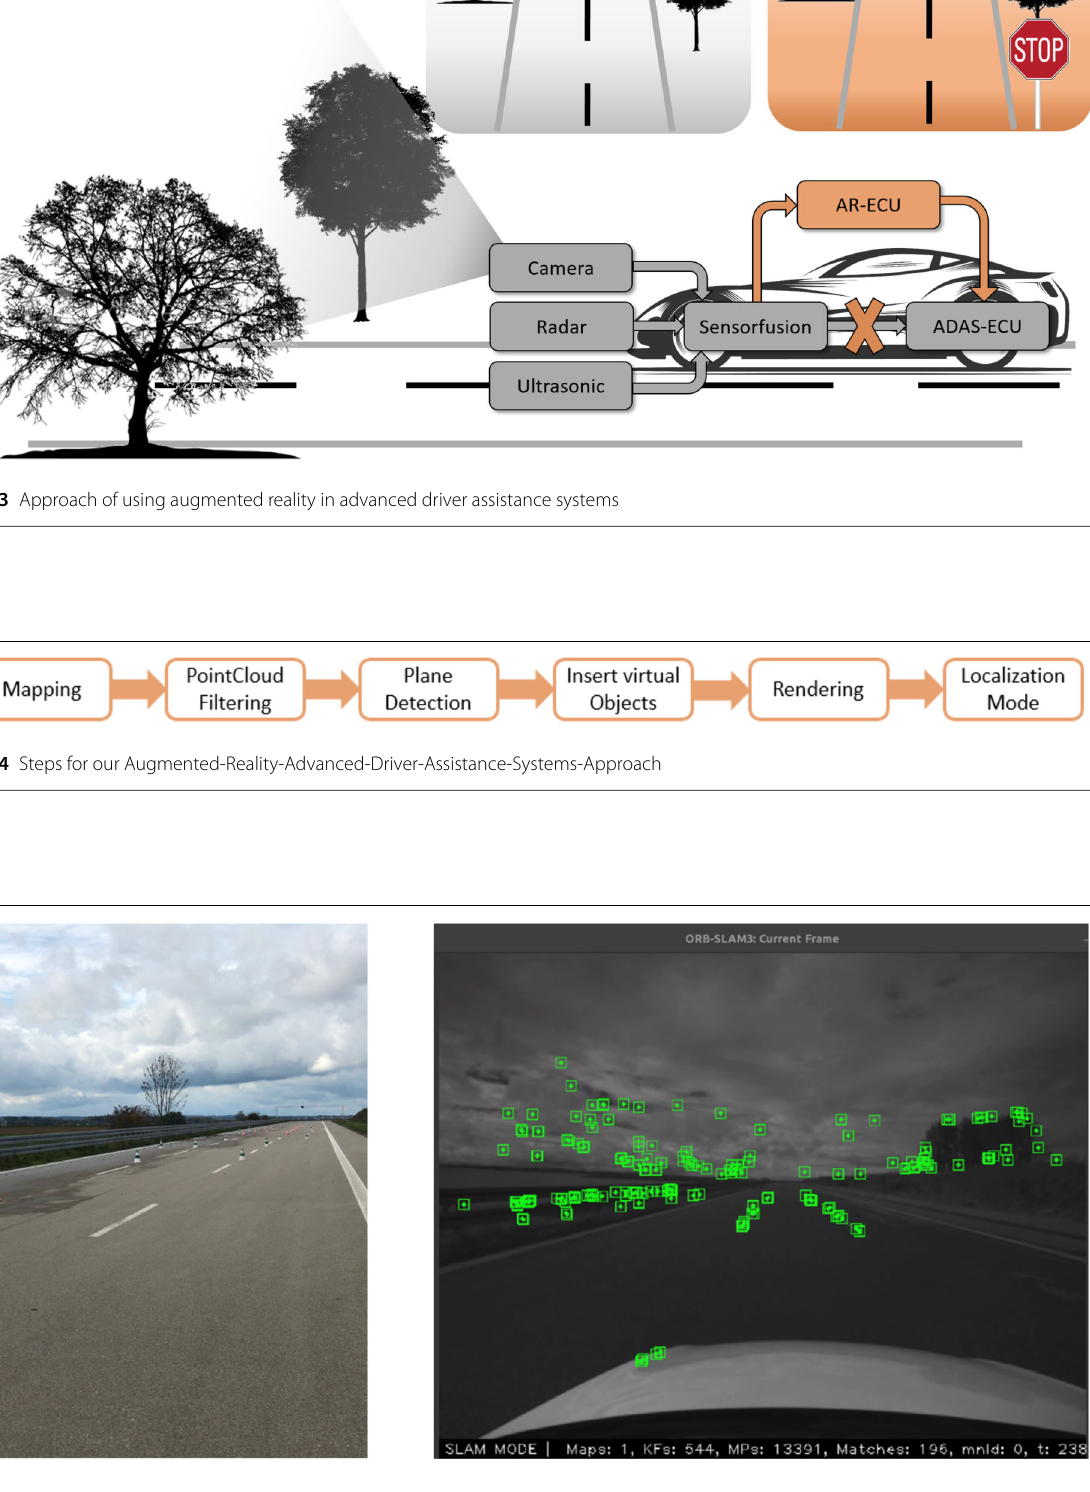
Figure 5 Test area on the left side of the figure with pylons and detected feature points using ORB-SLAM (green rectangles) on